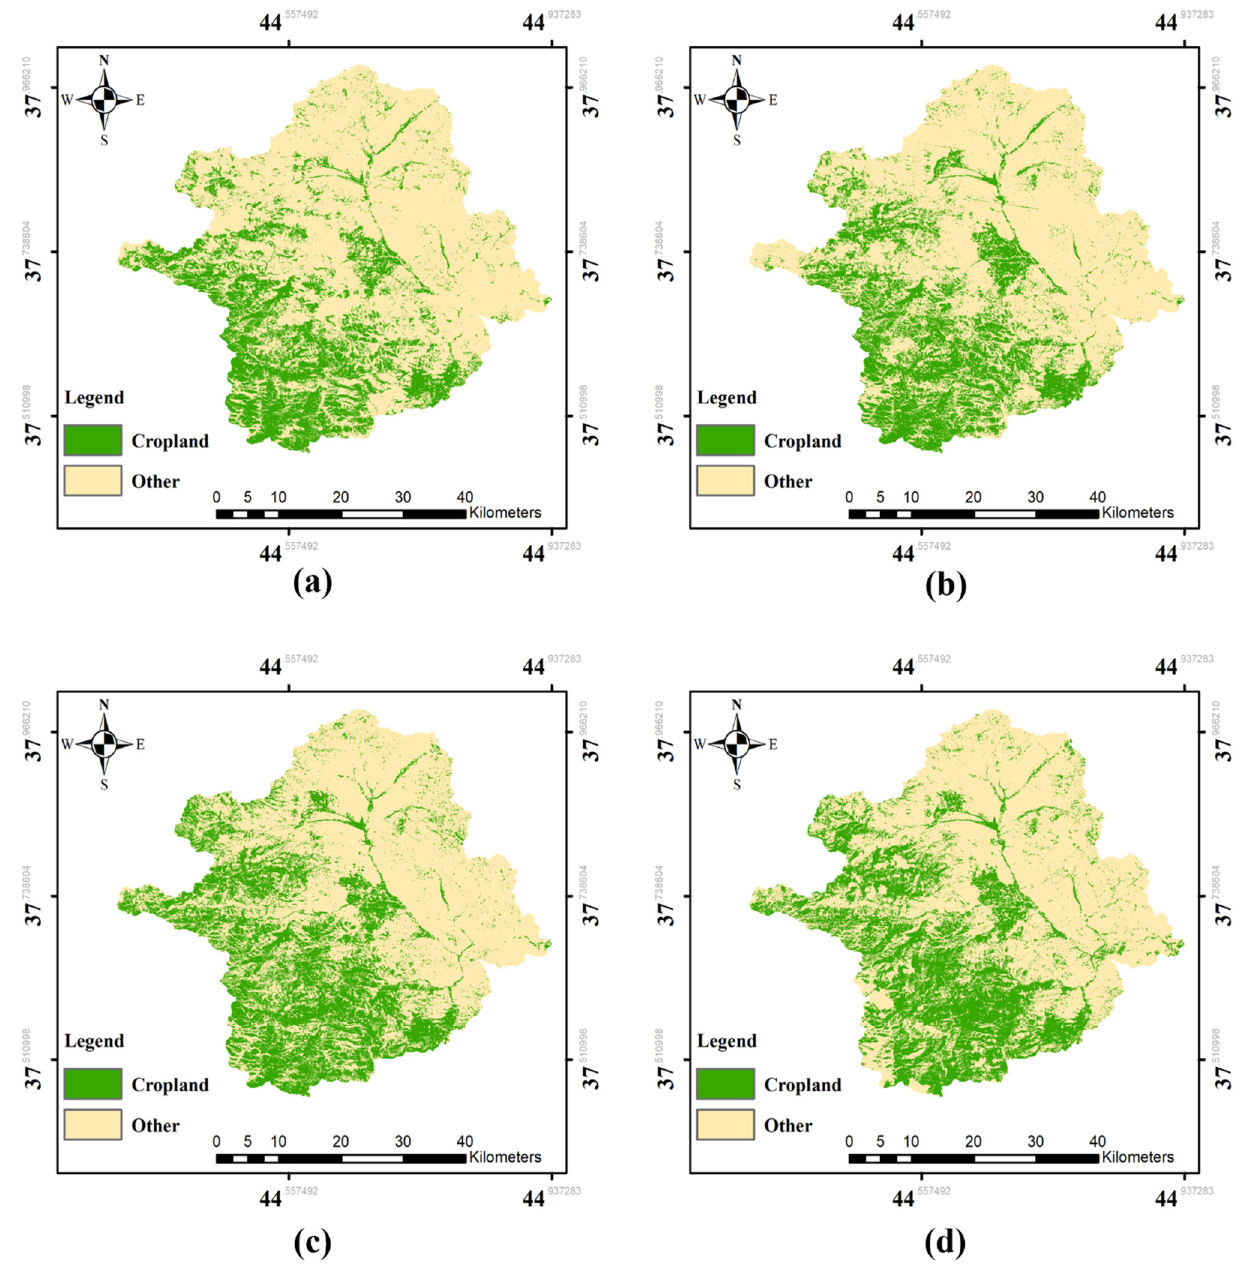
Figure 11. Land use maps for the NC watershed for ( a ) 1990, ( b ) 2000, ( c ) 2010, and ( d ) 2020.